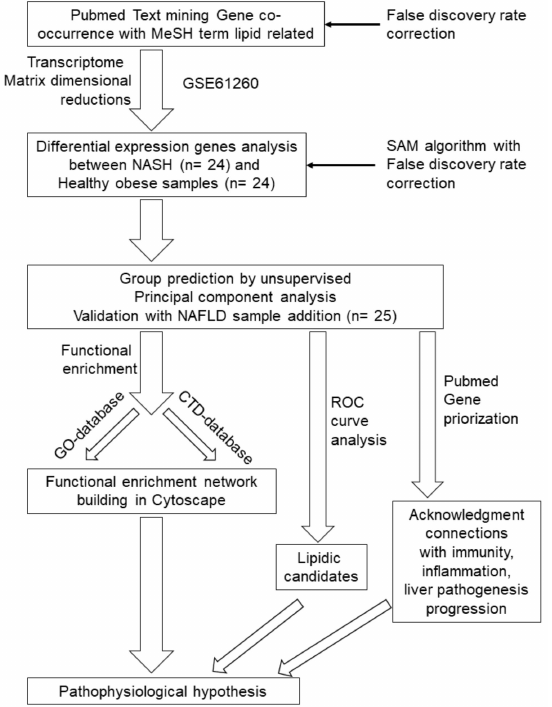
Figure 1. Workflow of analysis implemented from text-mining integration in transcriptome to pathophysiological hypothesis. CTD: comparative Toxicogenomics database; GEO: gene expression omnibus; GSE: genomic spatial event database, MeSH: medical subject headings; NAFLD: nonalcoholic fatty liver disease; NASH nonalcoholic steatohepatitis; ROC: receiver operating characteristic; SAM: statistical analysis of